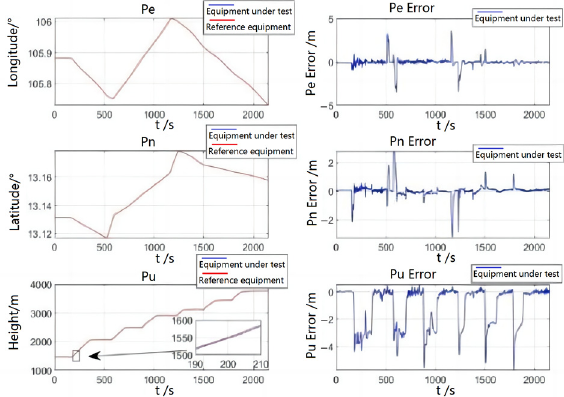
Figure 9. Flight test position comparison and error.